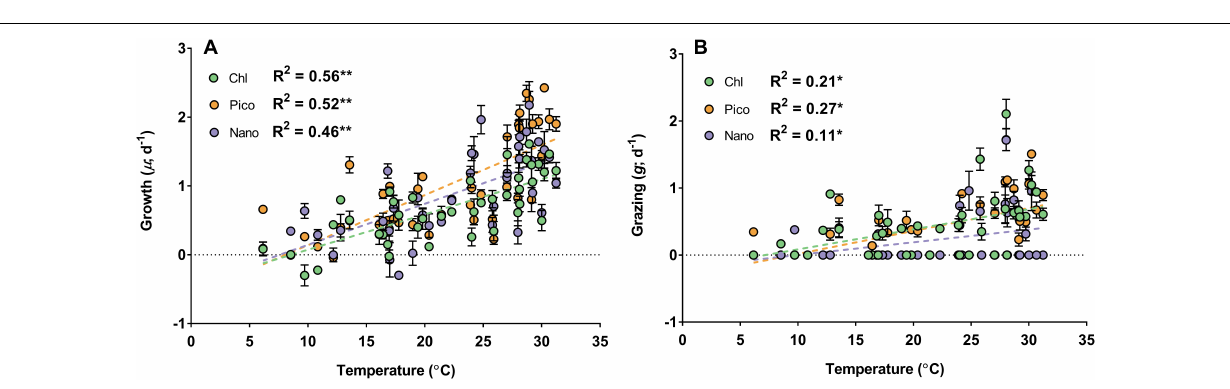
FIGURE 5 | Model 1 linear regressions (dotted lines) of phytoplankton growth (A) and microzooplankton grazing (B) vs. surface water temperature ( ◦ C) for chlorophyll (green), picoeukaryotes (orange), and nanoeukaryotes (purple). Values of coefficient of determination (R 2 ) indicate strength of linear relationship; regressions were significant for growth and grazing across all phytoplankton groups ( ∗ p < 0.05 and ∗∗ p <